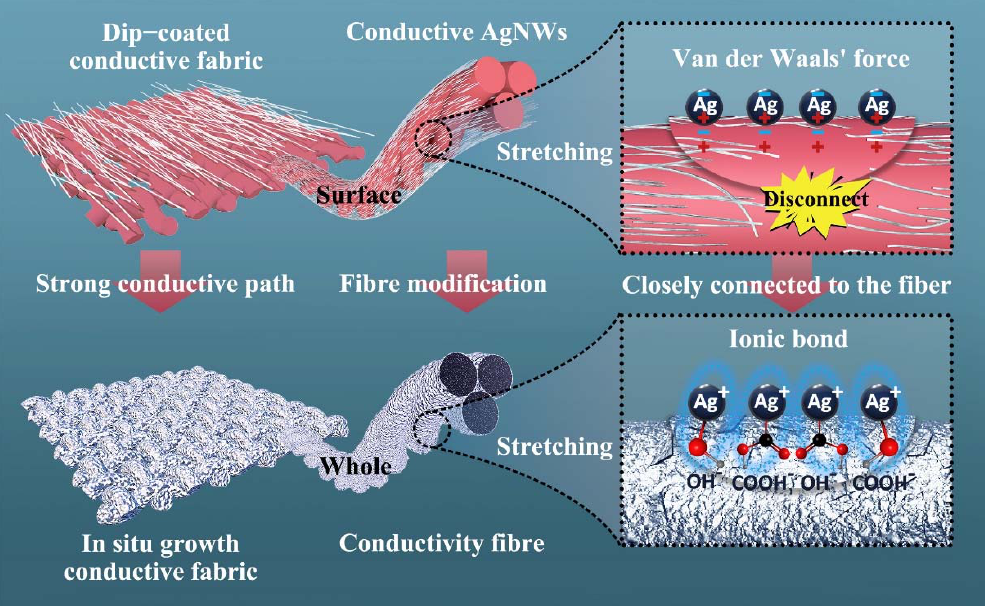
Figure 6. Tensile and electrical conductivity of conductive fabric by different processes.